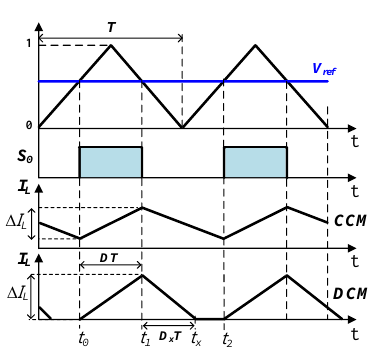
Figure 4. Key waveforms of the proposed SC DC-DC converter.